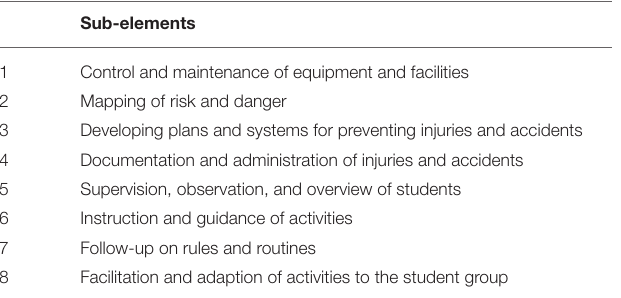
TABLE 1 | Content elements given in content of practice . TABLE 2 | Statements presented in description of